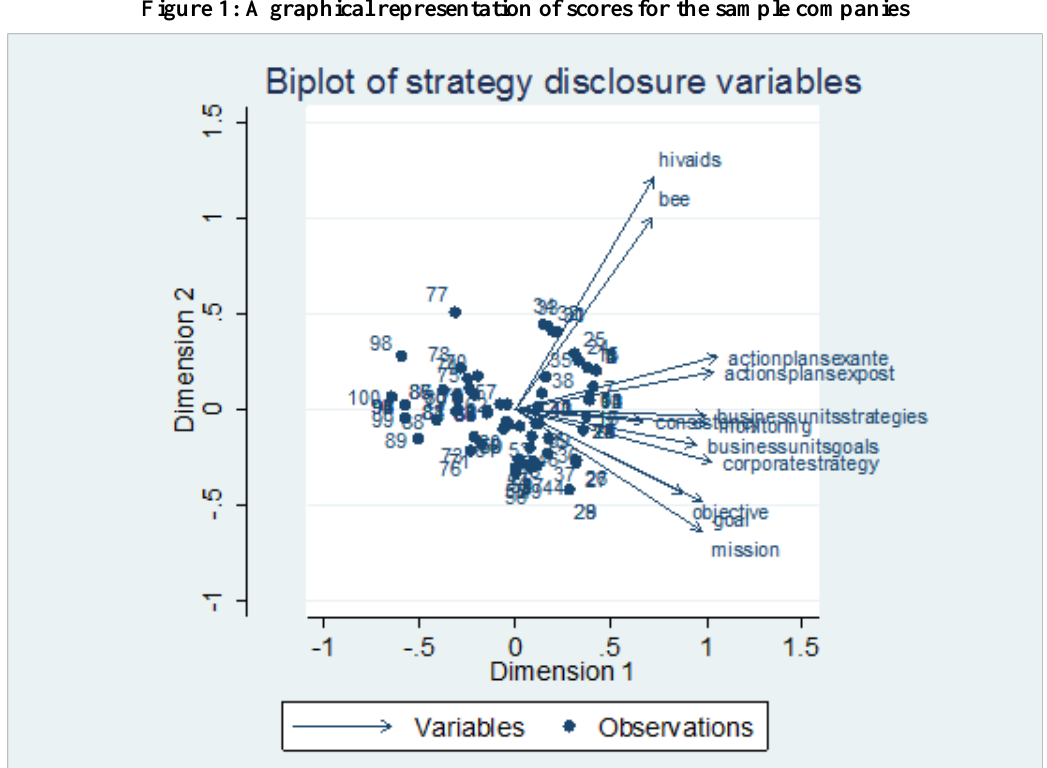
Figure 2: Biplot of strategy